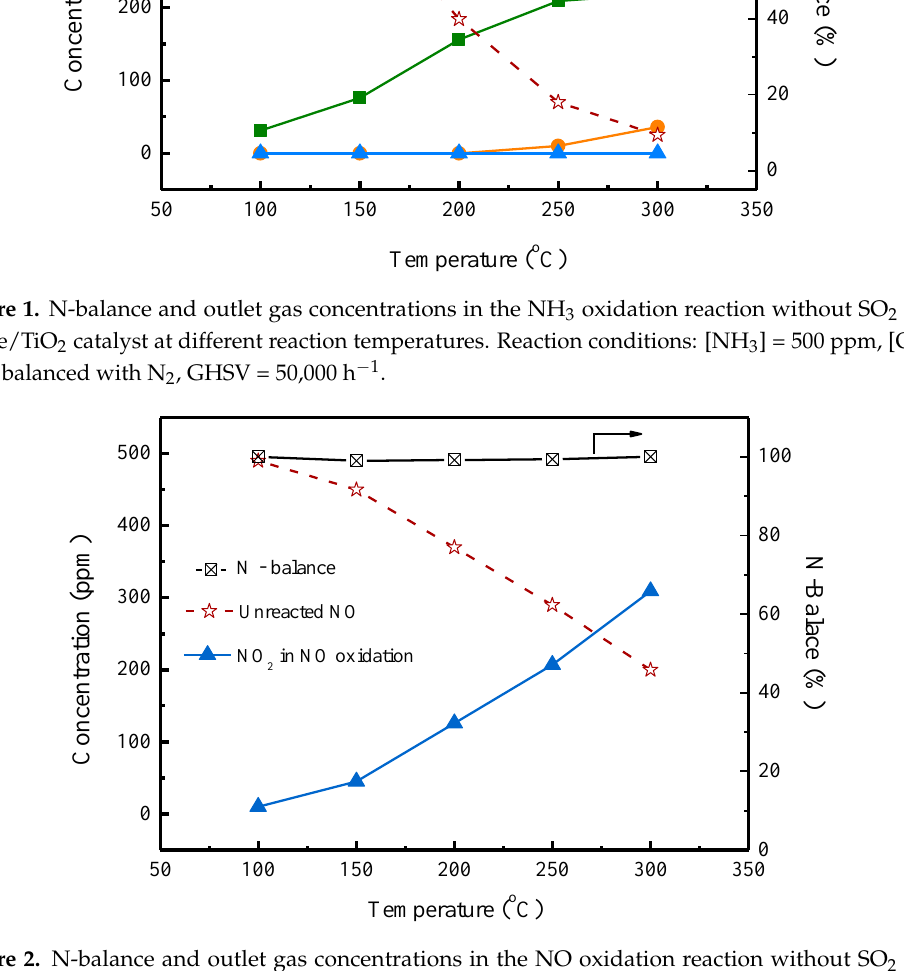
Figure 2. N-balance and outlet gas concentrations in the NO oxidation reaction without SO 2 over MnFe/TiO 2 catalyst at different reaction temperatures. Reaction conditions: [NO] = 500 ppm, [O 2 ] = 10%, balanced with N 2 , GHSV = 50,000 h −1 .